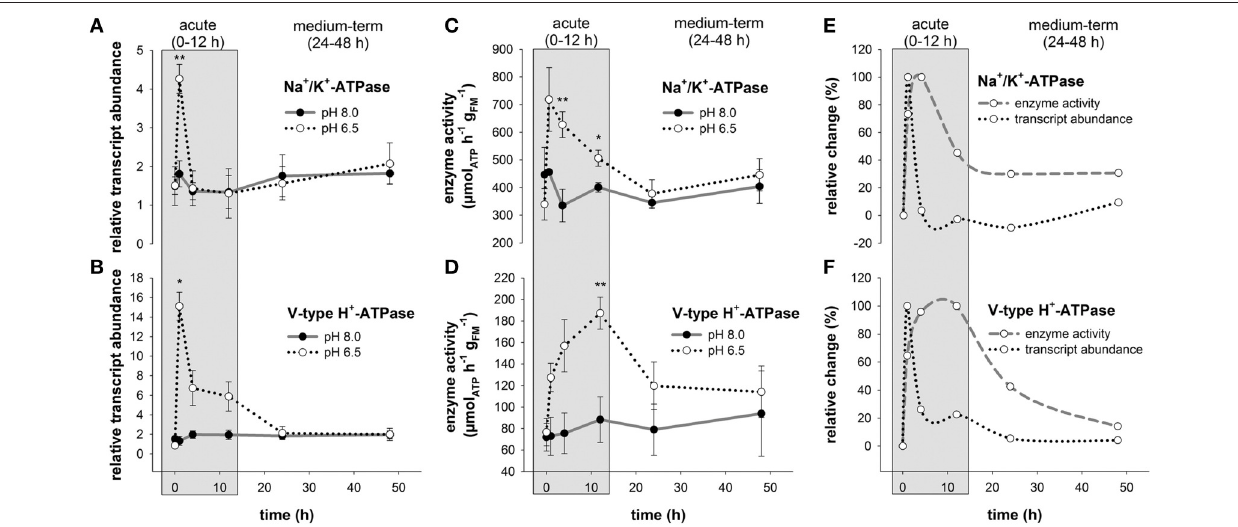
FIGURE 3 | Branchial Na + /K + -ATPase and V-type H + -ATPase transcript abundance and enzyme activities during acclimation to acidified conditions. Relative changes in Na + /K + -ATPase (NKA) (A) and V-type H + -ATPase (VHA) (B) transcript levels under control and acidified conditions. Transcript levels were normalized to arginine kinase (AK) as an internal control. NKA (C) and VHA (D) enzyme activities in control and low pH treated animals along the experimental period of 48h. Combined presentation of relative changes in NKA (E) and VHA (F) mRNA levels and enzyme activities normalized to control animals. The exposure period is separated into a short-term (gray) and medium-term (white) acclimation period. Asterisks indicate significant differences between pH treatments ( * p < 0.05 and ** p < 0.001 ). Bars represent mean ± SE ( n = 3